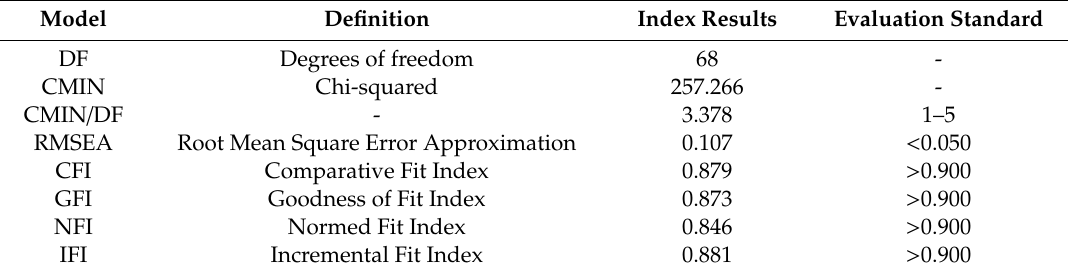
Table 2. Comparison of the theoretical model fit index results with the evaluation